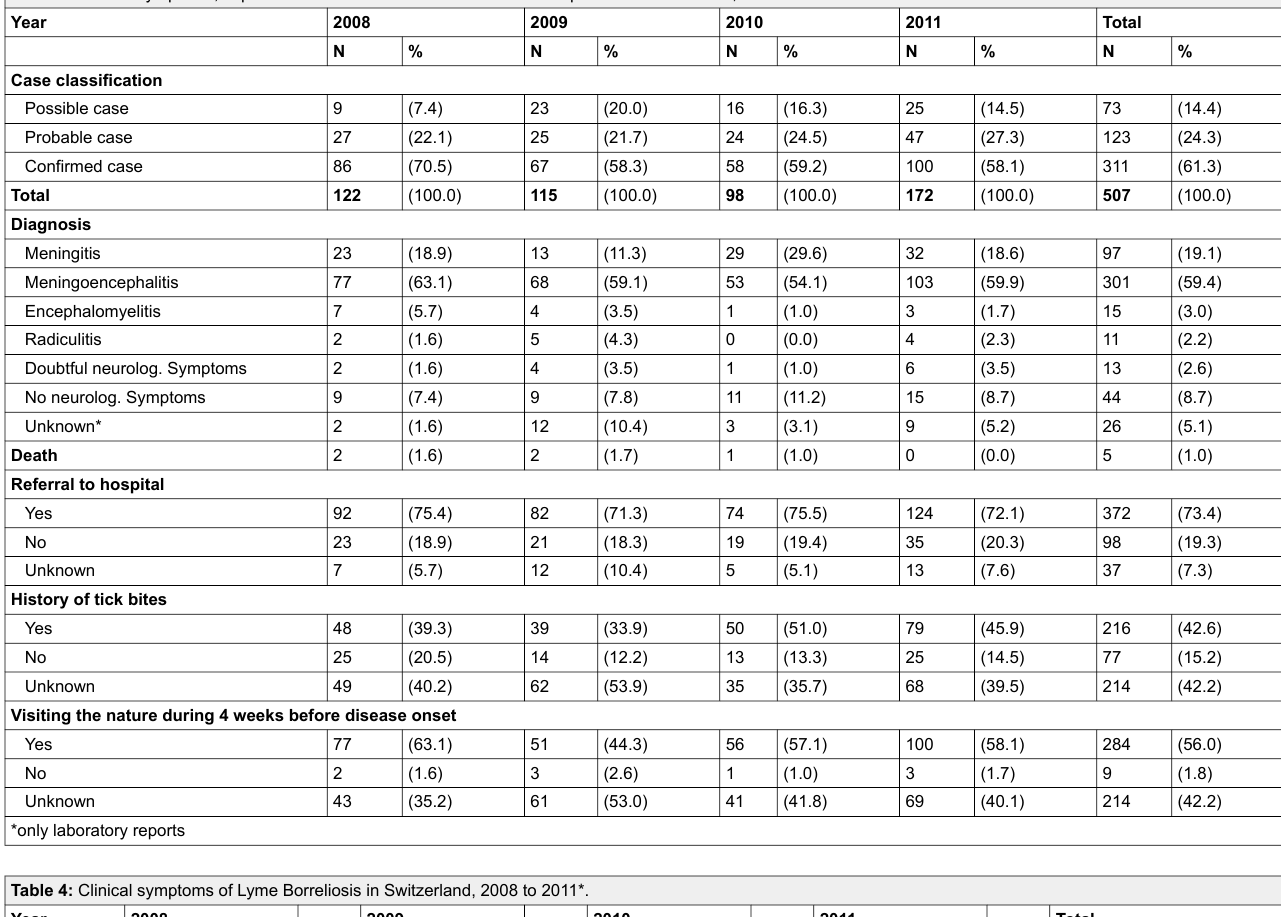
Table 3: Clinical symptoms, exposure and further details of tick borne encephalitis in Switzerland, 2008 to 2011.